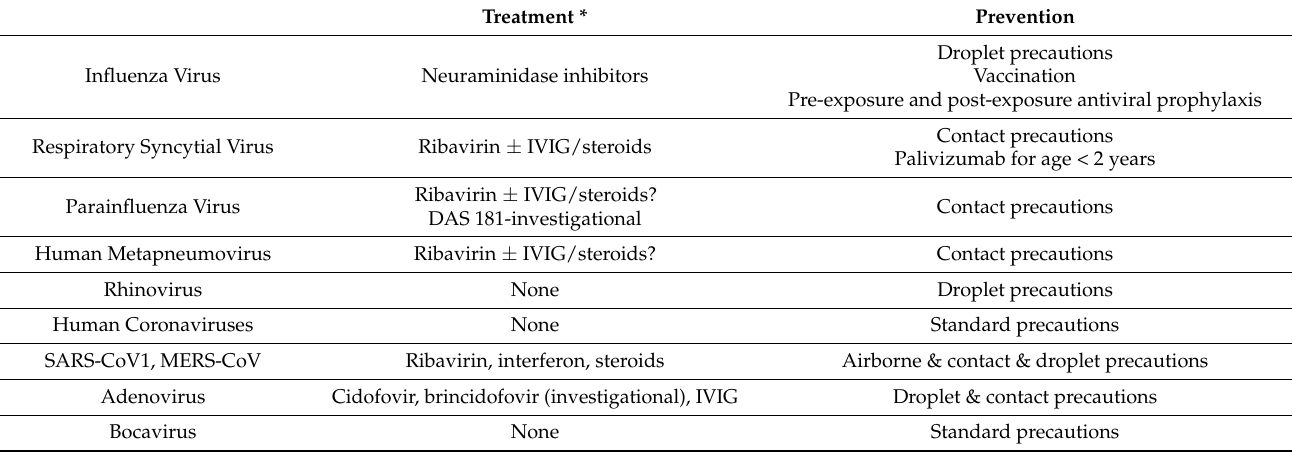
Table 1. Treatment and preventive measures for respiratory viral infections.